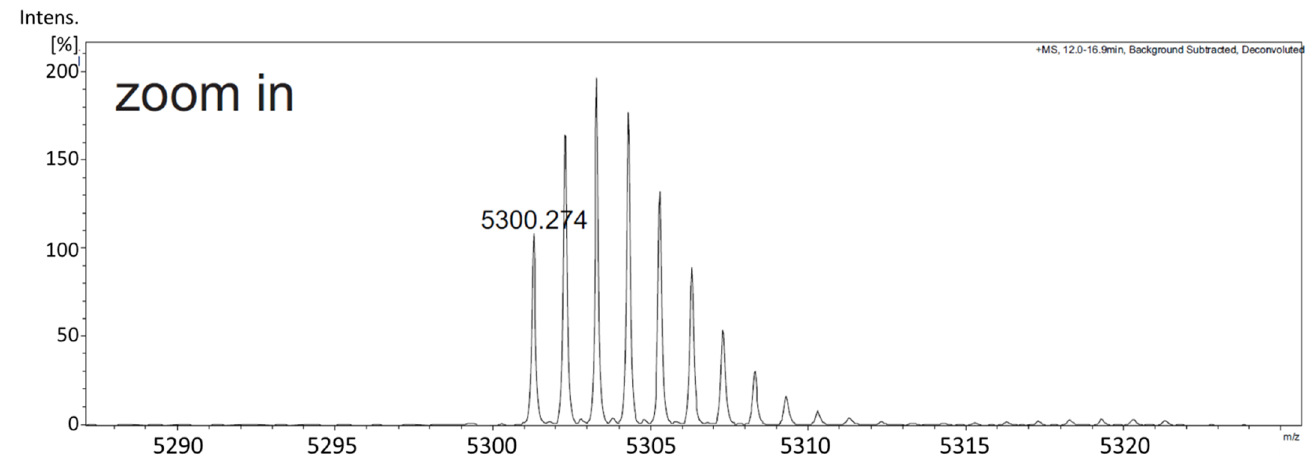
Figure 9. ESI-MS of purified At3g59930 peptide. Measured mass 5300.274 indicates the expected